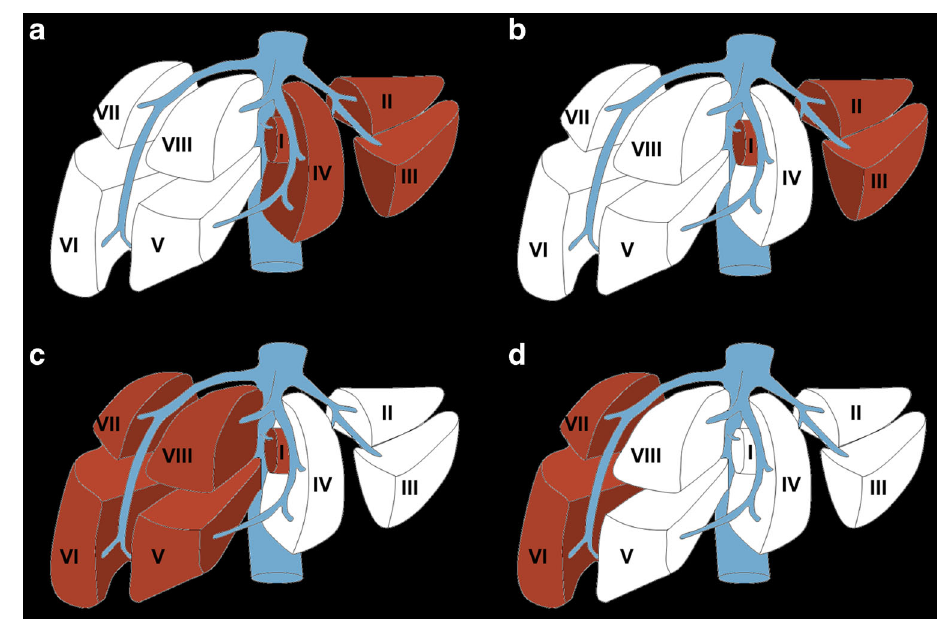
Fig. 2 Types of major hepatectomy. White segments are planned for surgical resection. a Complete right hepatectomy. b Extended right hepatectomy. c Complete left hepatectomy. d Extended left hepatectomy. Figure adapted from the Brisbane